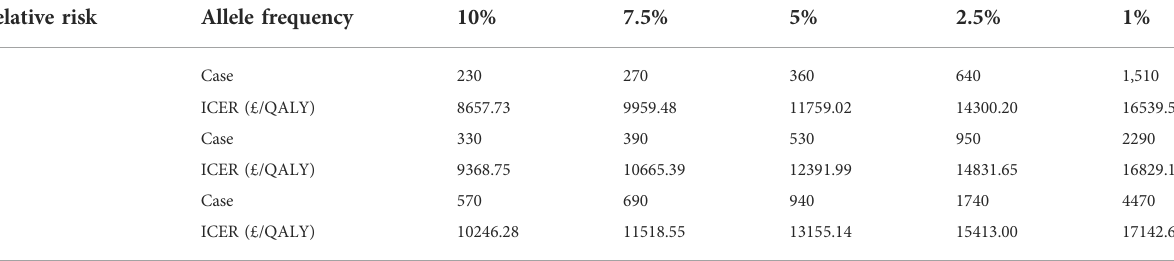
TABLE 2 The number of cases to obtain 80% power under various relative risk and allele frequency of SNPs, and ICER for each model. Relative